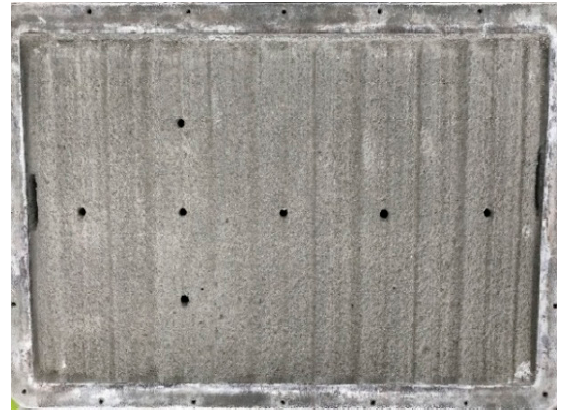
Figure 5. The roughness fracture simulation model.